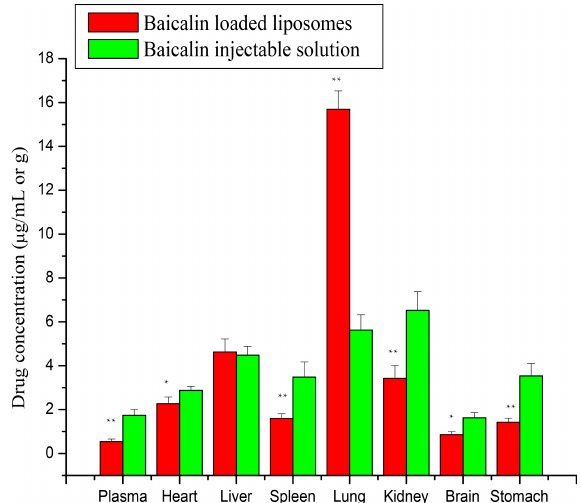
Figure 11. Distribution in plasma and tissues after via intravenous administration of baicalin loaded liposomes and its injectable solution at a dose of 10 mg/kg to rabbits. Each point represents the mean + SD ( n = 5). ** p < 0.01 compared with baicalin injection; * p < 0.05 compared with baicalin injection.